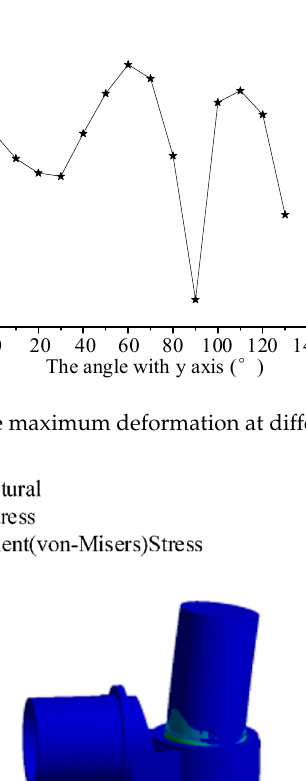
Figure 11. The milling stress nephogram of the maximum deformation position.